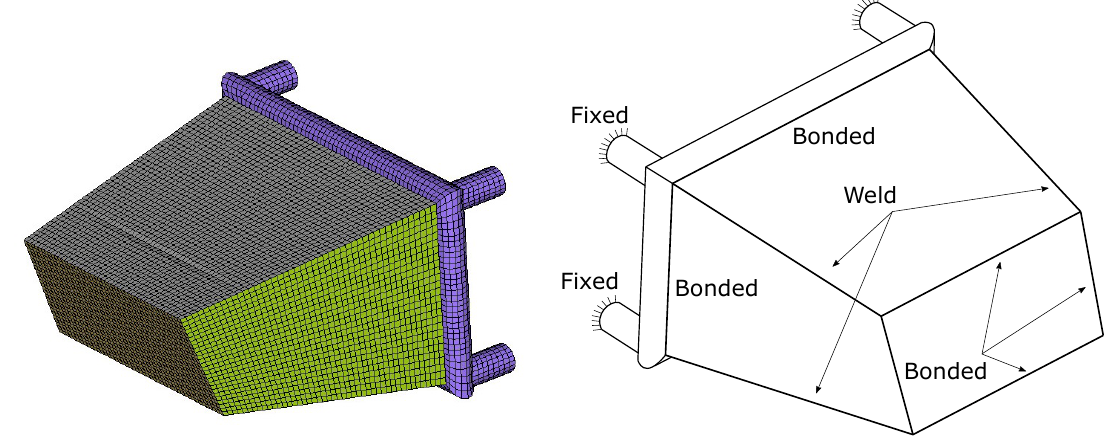
Figure 8. Mesh of the model with the front part of the chassis ( left ) and boundary conditions ( right